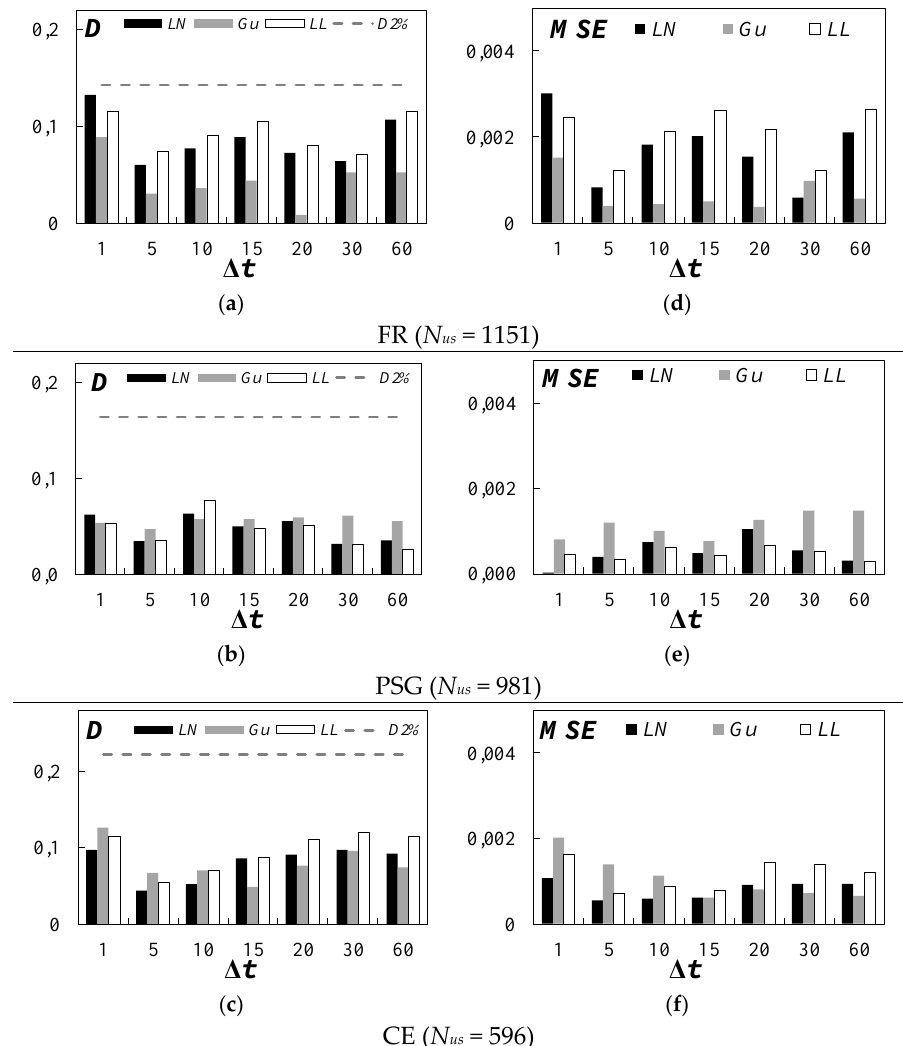
Figure 6. Effects of the time aggregation—KS parameter and MSE versus ∆ t.